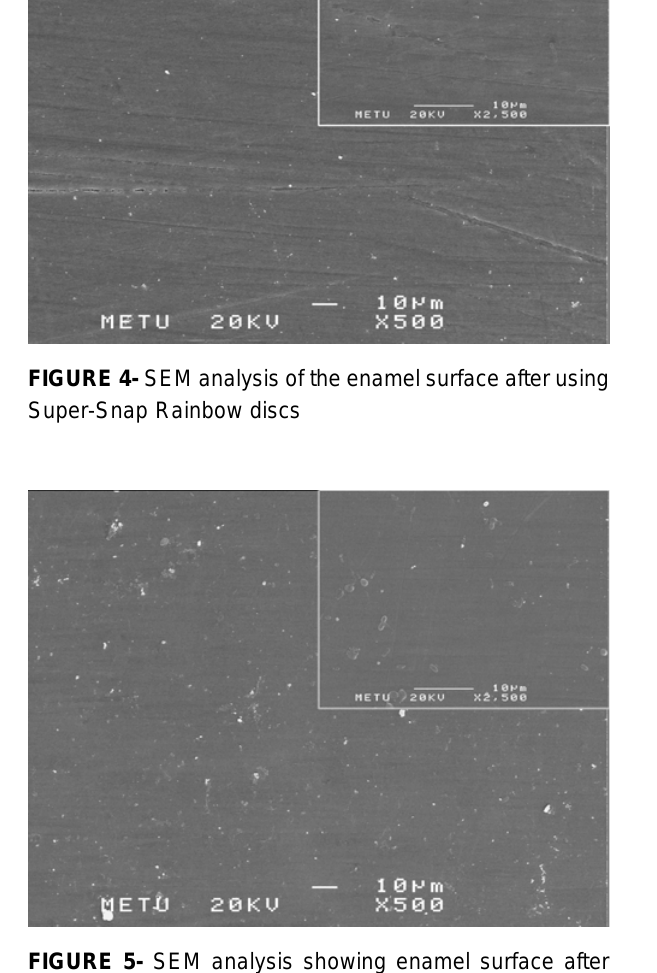
FIGURE 5- SEM analysis showing enamel surface after using diamond coated Po-Go micro-polisher point